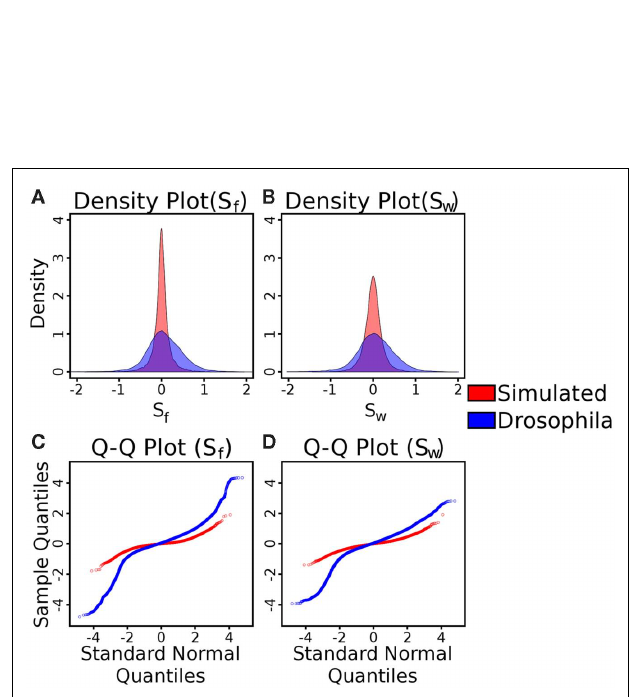
FIGUREA4 |Tests of the distributions of the S f and S W statistics in simulated and Drosophila (C1 and C2) control versus control data. (A) Density plots of simulated (red) and Drosophila (blue) control S f data (blue). (B) Density plots of simulated (red) and Drosophila (blue) control S W data. As can be seen in both cases, with C1 and C2, the variance of the statistic is much higher than in the simulated control data. (C) Quantile-quantile plots of simulated (red) and Drosophila (blue) control S f data, compared to a standard normal distribution. (D) Quantile-quantile plots of simulated (red) and Drosophila (blue) control S W data, compared to a standard normal distribution. In these plots, a straight line indicates that the data comes from a normal distribution. In all cases, the plots indicate a non-normal distribution (quantified by the Lilliefors test for normality as having P -values less than 2.2 × 10 − 16 ).